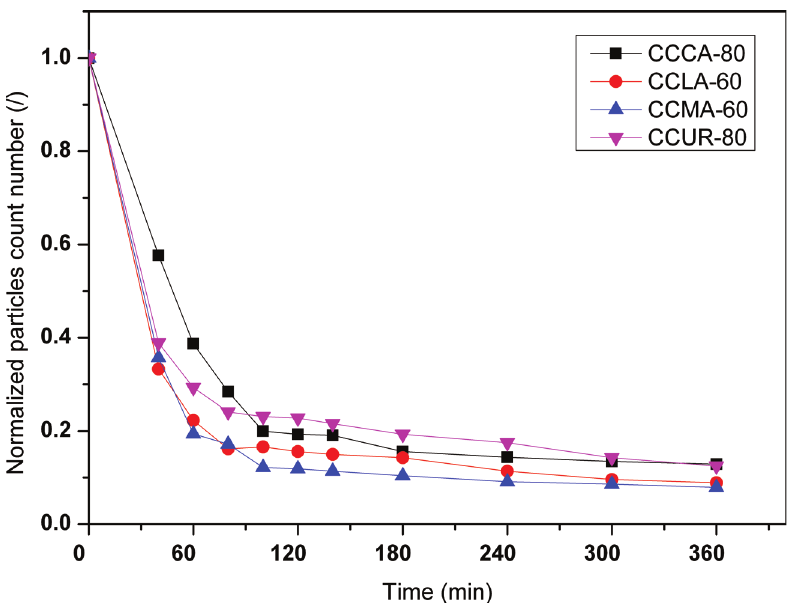
Figure 2: Shrimp shell powder dissolution dynamics in NADES, with the real-time measurement of total particle number (normalized) in the range from 1 to 1000 µm. Temperatures for different NADES were CCCA (80°C), CCLA (60°C), CCMA (60°C) and CCUR (80°C), 100 min –1 , 50 mL of NADES and 1 g of shrimp shell